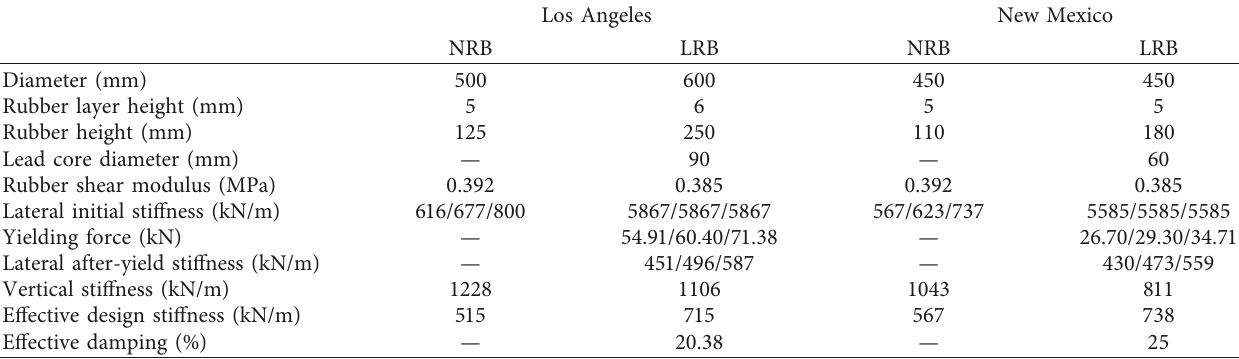
Table 16: Parameters of the isolators (minimum/nominal/maximum) for the hospital buildings.